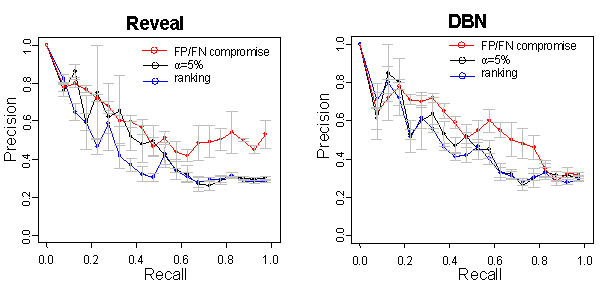
Precision vs Recall for simulated data. Average Precision at different Recall intensities obtained on 100 simulated data sets, using Reveal (left panel) and DBN (right panel).